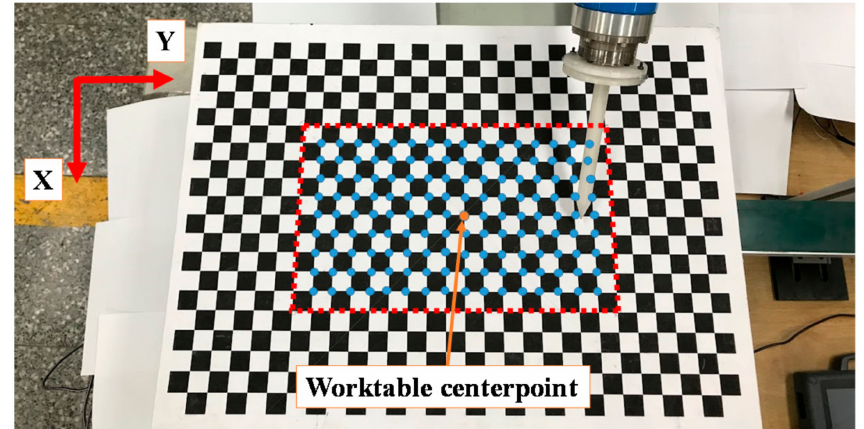
Figure 14. Initial position of robot and conveyor and gripping